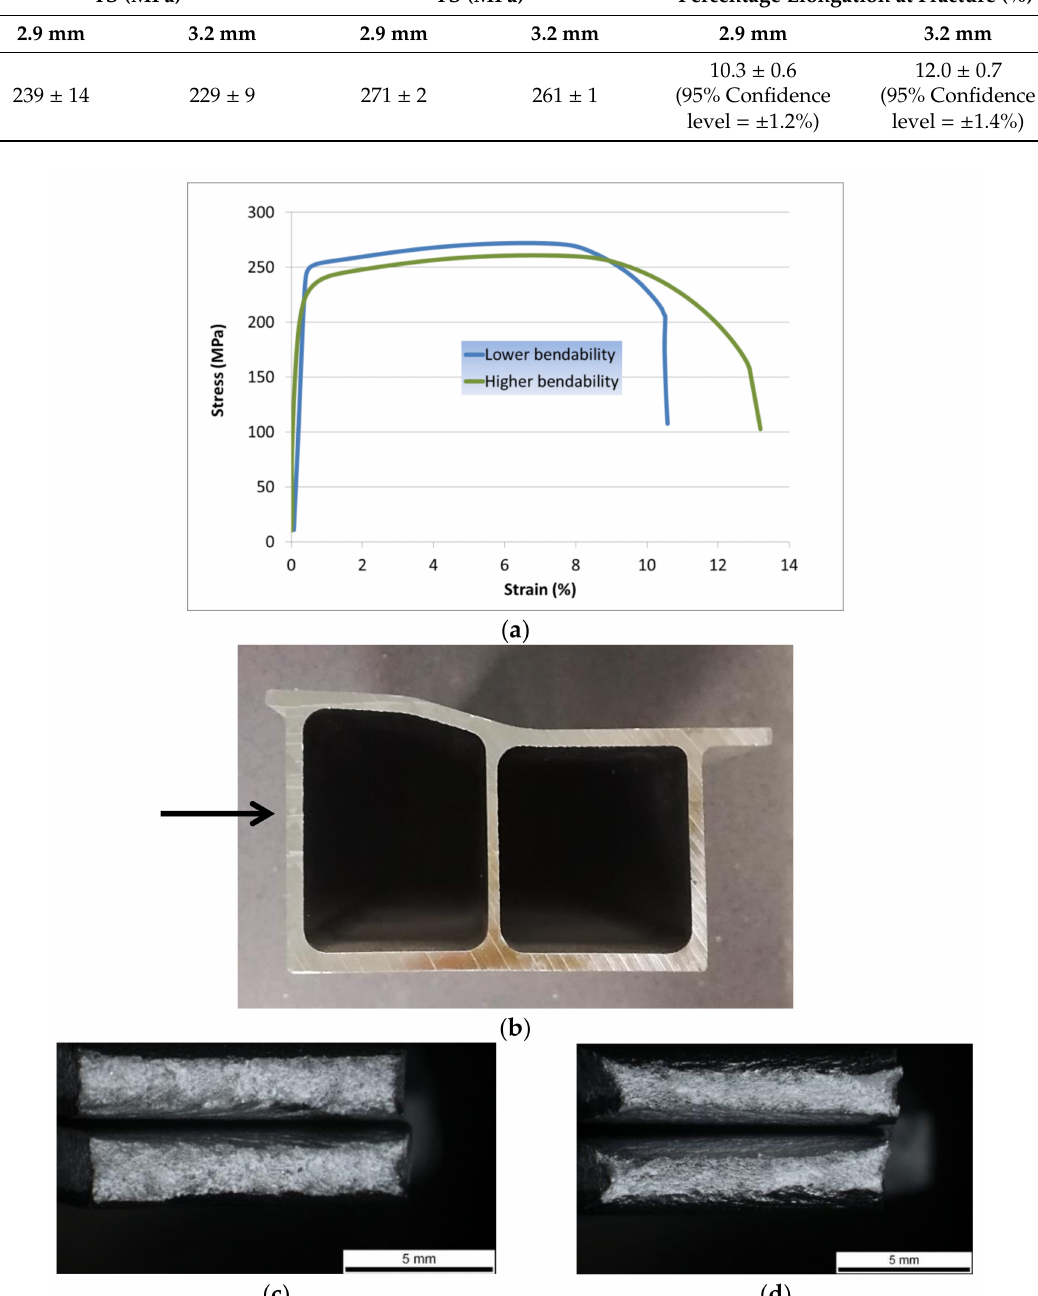
Figure 5. ( a ) Stress-strain curves showing lower strength and higher ductility for the thicker sample. ( b ) Macrograph of the aluminum profile cross-section, showing the wall area from which the mechanical testing specimens were retrieved, the wall thickness corresponds to the initial tensile specimen thickness. Stereoscopic micrographs of the fracture surfaces from tensile tests, ( c ) 2.9 mm thick sample and ( d